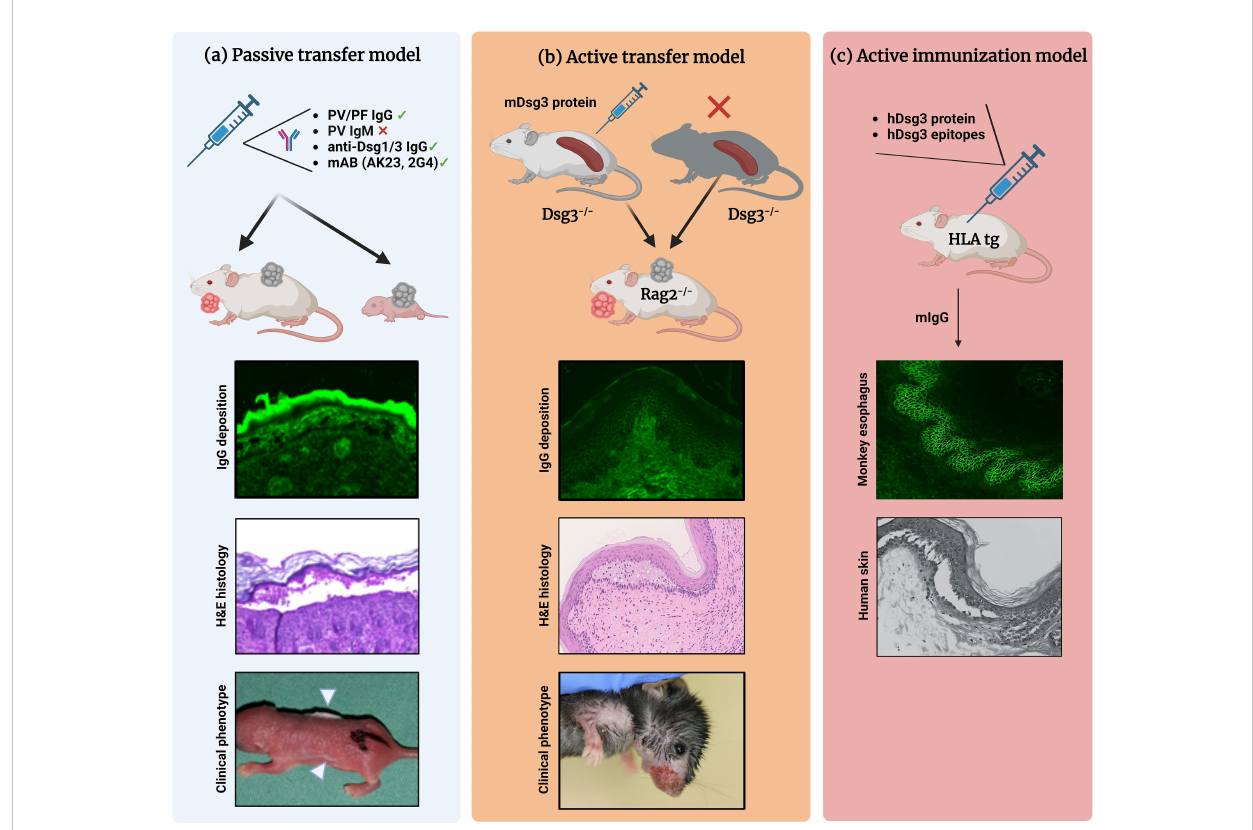
FIGURE 1 Different mouse models of pemphigus. (A) Antibody transfer-induced ( “ passive ” ) models. Total pemphigus vulgaris (PV) or pemphigus foliaceus (PF) IgG fractions, anti-desmoglein (Dsg) 1/3 IgG isolated from patients ′ sera, or monoclonal anti-Dsg3 antibodies (e.g., AK23, 2G4) are injected into adult or neonatal mice leading to blister formation. Direct immuno fl uorescence (IF) microscopy, hematoxylin and eosin (H&E)-stained histology, and clinical presentation (white arrowheads indicate the blister sites) of a neonatal mouse injected with puri fi ed IgG from a patient with PV. (B) Lymphocyte transfer-induced models. Following adoptive transfer of naive lymphocytes from Dsg3 -/- mice or splenocytes from Dsg3 -/- mice immunized with recombinant Dsg3 protein, Rag2 -/- immunode fi cient mice produce anti-Dsg3 IgG antibodies and display the PV phenotype, allowing us to study the loss of tolerance. (C) Immunization-induced models. Immunization of humanized HLA-DBR1*04:02 transgenic mice with human Dsg3 recapitulates the effector phase of T and B cells followed by the formation of pathogenic Dsg3-speci fi c IgG formation. Binding of the murine IgG from immunized mice to the keratinocyte cell surface was con fi rmed by indirect IF staining on monkey esophagus. Injection into human skin with murine IgG resulted in intraepidermal acantholysis and typical pathology. Figure was created with